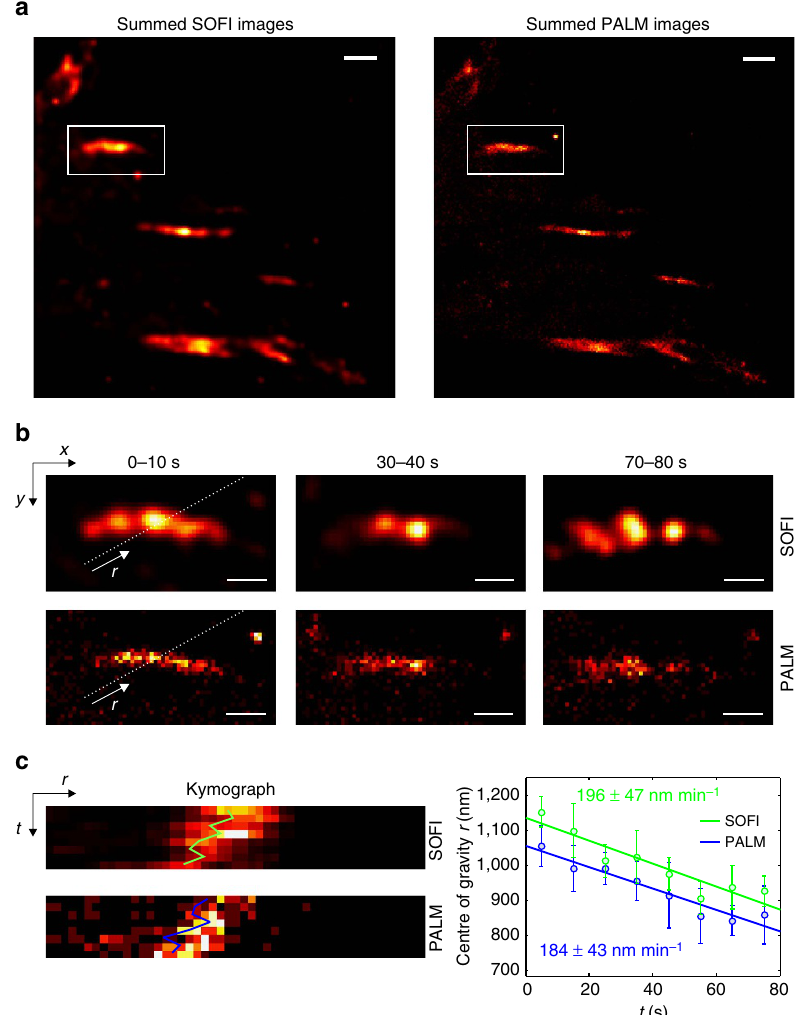
Figure 4 | Live-cell imaging with PALM and SOFI. ( a ) Sum of eight PALM and SOFI images of a living MEF cell expressing paxillin labelled with mEos2. Each image is reconstructed from 1,000 camera frames with 10ms exposure time, resulting in a 10s temporal resolution. The PALM images were rendered as localization number histograms (see Methods) with a pixel size equal to the SOFI pixel size. Scale bar, 1 m m. ( b ) Region of interest indicated in a showing a focal adhesion at different time points. Scale bar, 0.5 m m. ( c ) Kymographs along the direction of motion as indicated by the line in b . The focal adhesion mean velocity is determined by a linear fit to the centre of gravity r determined from the kymograph as a function of time (see Methods). The procedure was repeated five times for parallel kymographs, the error bar represents the